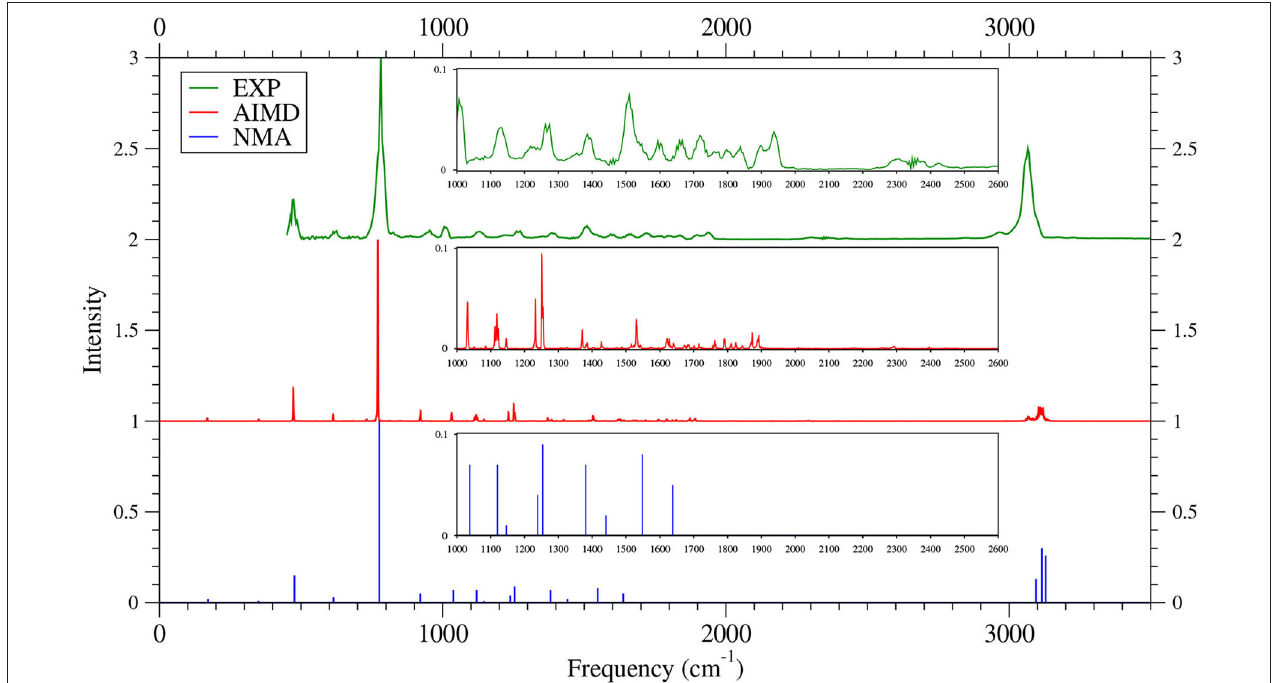
FIGURE 6 | IR spectra of 2-acene, obtained with the TAO-AIMD simulations at 300 K and GS-NMA, calculated by TAO-LDA. Experimental (EXP) data (NIST mass spectrometry data center, 2020 ) are included for comparison. The IR spectra are normalized to have a maximum intensity of one and, for clarity, are vertically offset from each other by the same value. Subfigures show the IR spectra in the 1,000–2,600 cm − 1 range.